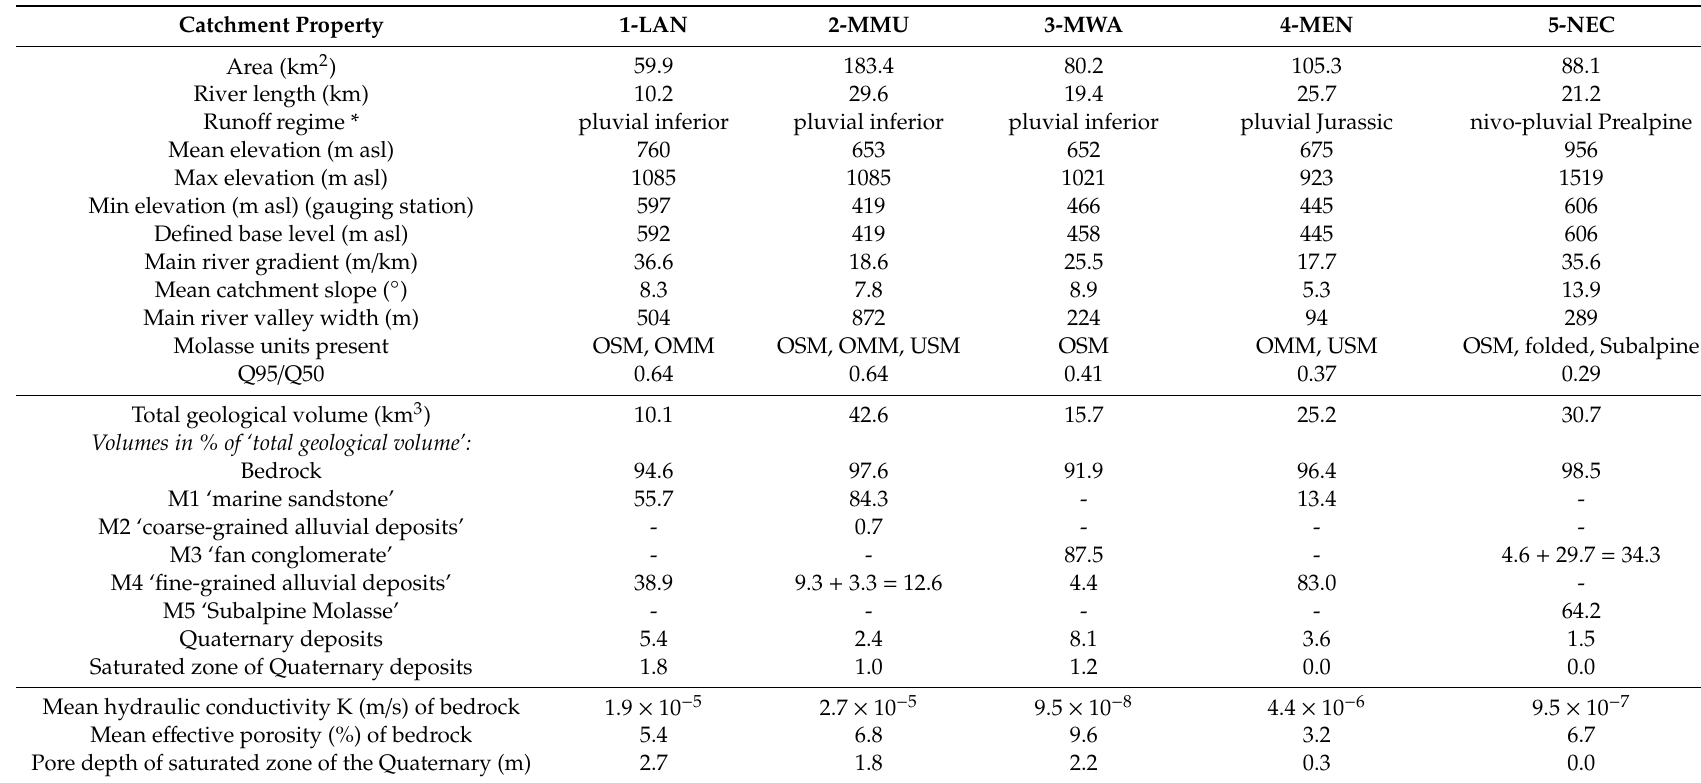
Table 3. Geomorphological and hydrological properties, as well as results of calculations of geological volumes and of hydrogeological parameters, of the five investigated